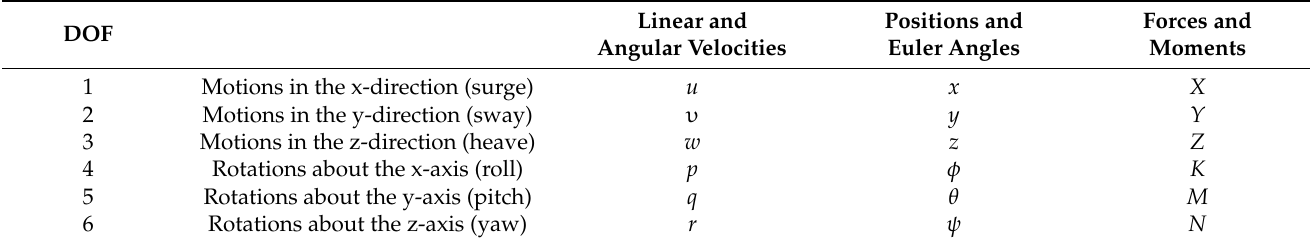
Table 1. The notation for torpedo-like underwater vehicles.